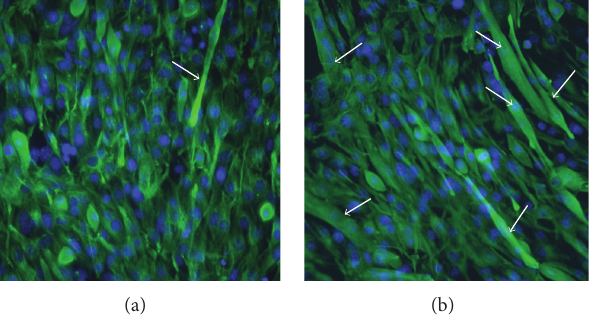
Figure 2: Multinucleated myofibers in representative muscle tissue sheets (90% C2C12 and 10% Nor-10) cultured in (a) control medium or (b) fCM. Arrows indicate myofibers that stained positive for muscle-specific Desmin (green) and nuclei (blue). Both tissue sheets were fixed at D1 of differentiation.